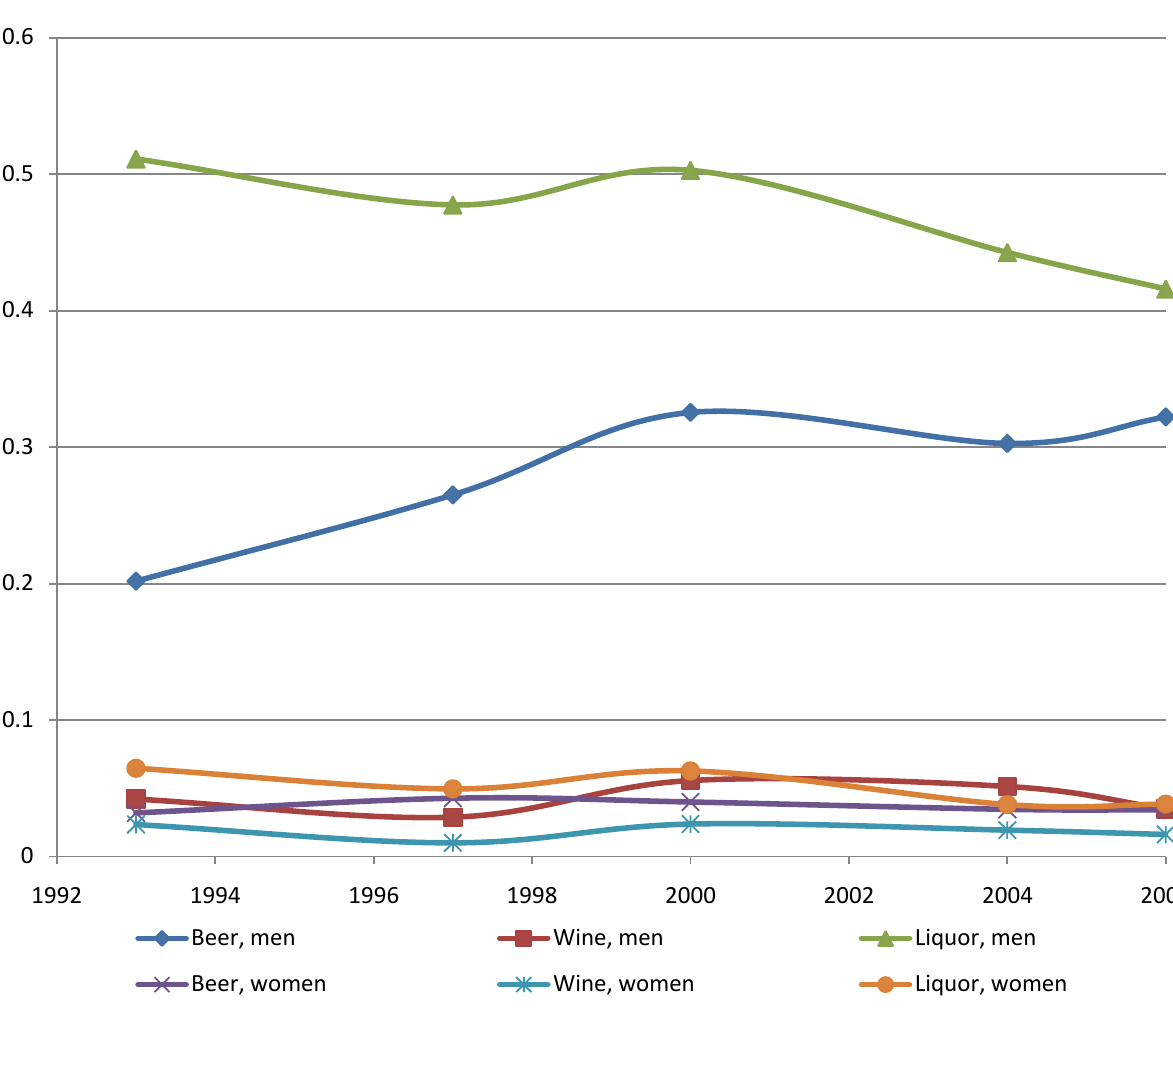
Figure 1. Probability of alcohol consumption by sex and by the type of